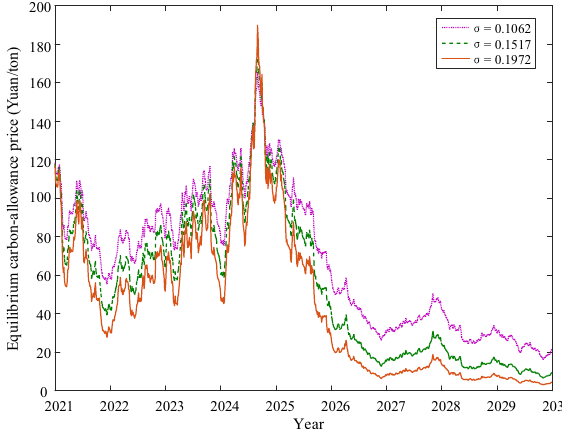
Fig. 9 Equilibrium prices of carbon allowances corresponding to different volatility